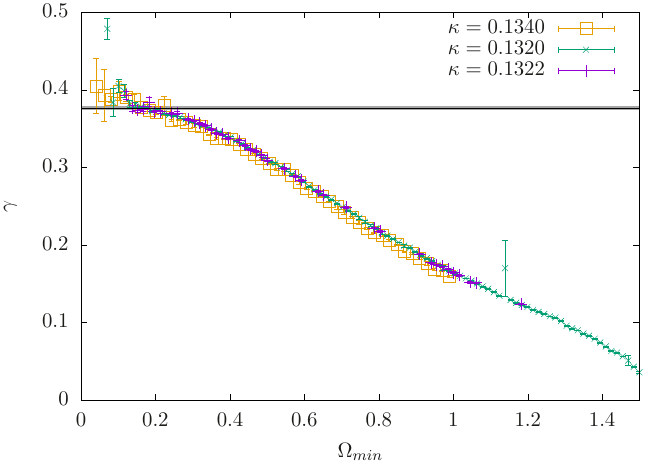
Figure 8 . Fitted value of the mass anomalous dimension for the ensemble at (cid:12) = 1 : 7, (cid:20) = 0 : 1322 (ensemble Q), (cid:20) = 0 : 1320 (ensemble N), and (cid:20) = 0 : 1340 (ensemble R3), as in (cid:12)gure 7. Ensembles N and R3 are only shown for comparison. Fits of the data from ensemble Q with a correlated (cid:31) 2 per degree of freedom larger than 4 have been excluded from the (cid:12)gure. The (cid:12)nal value represented by the shaded region in the plot is only obtained from a (cid:12)t in the plateau region of ensemble Q.